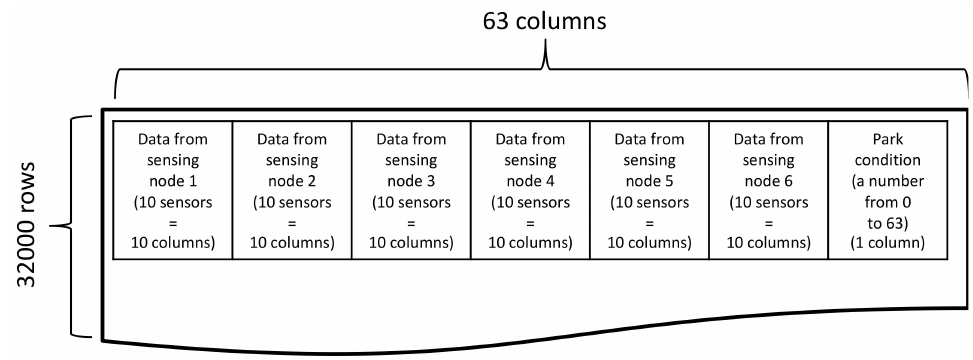
Figure 9. Table description of the input matrix used by the algorithm for emergency